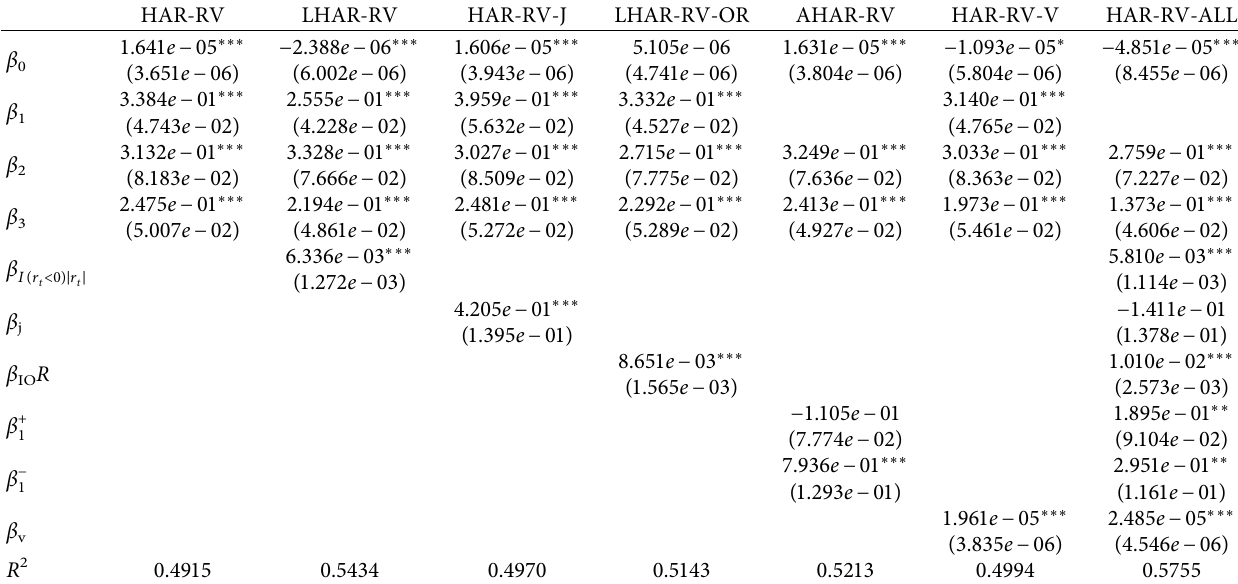
Table 2: Estimation results for the models with constant